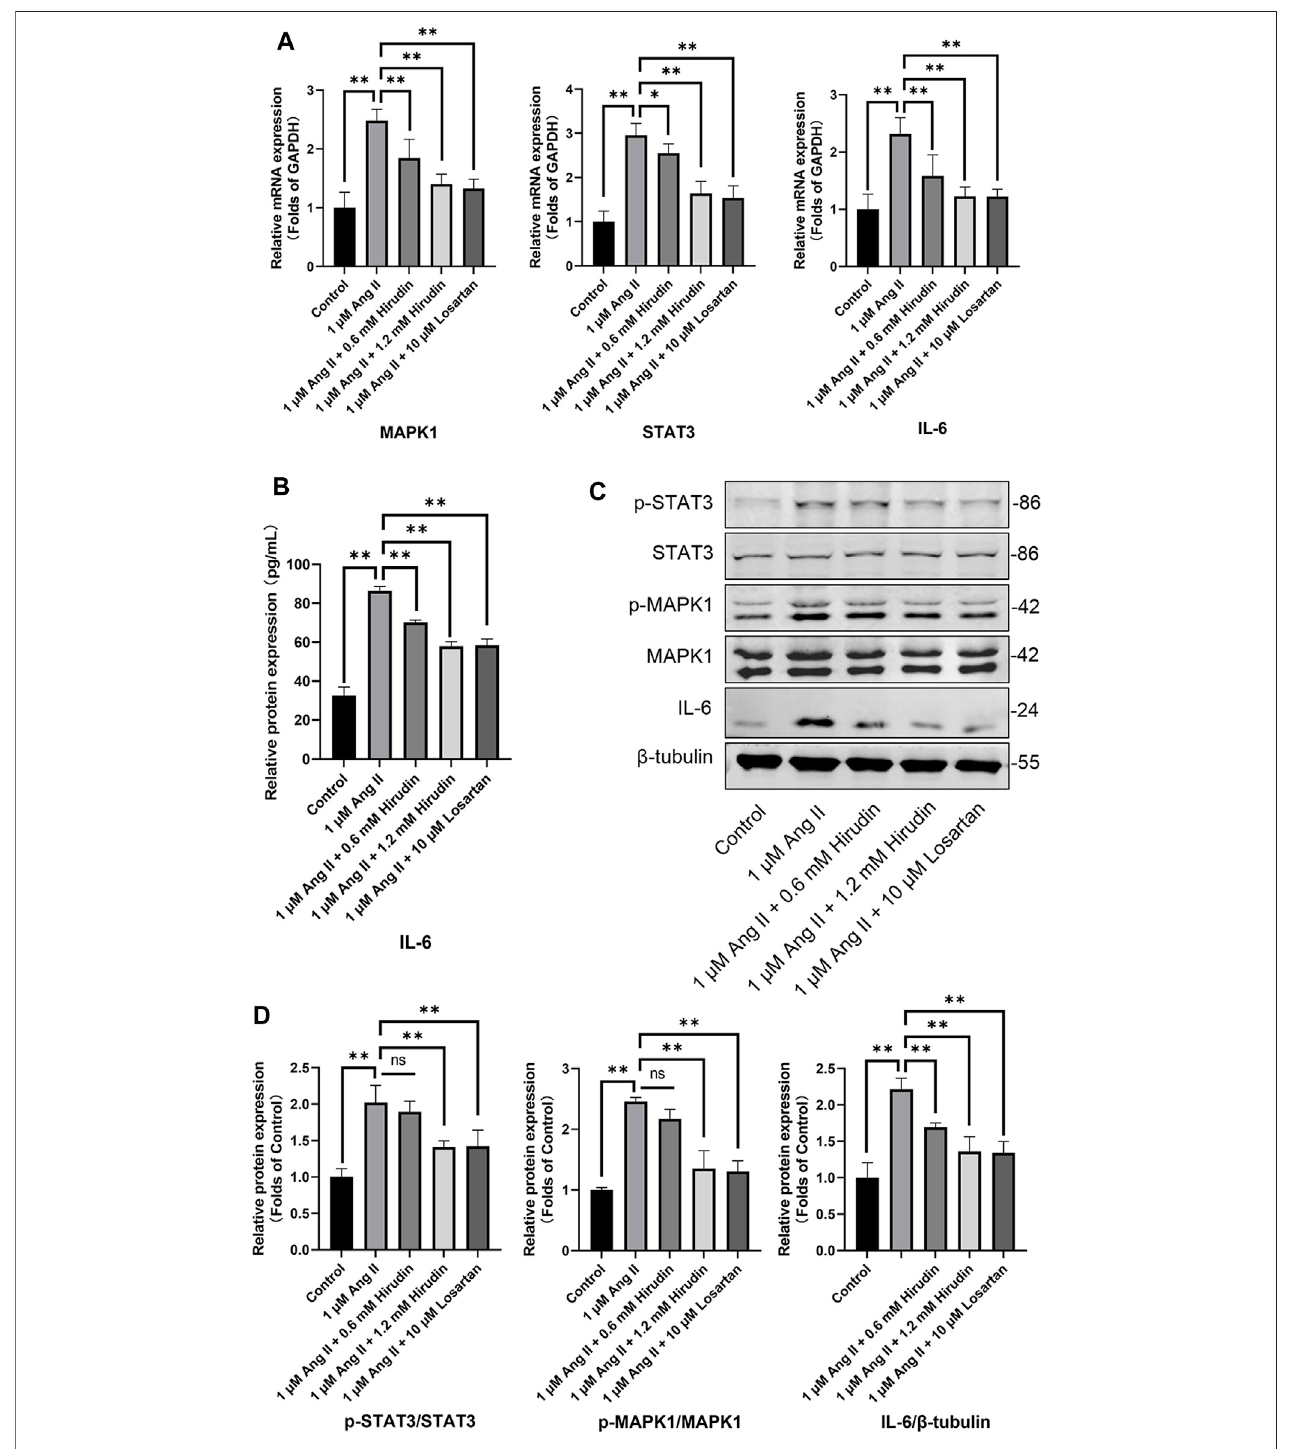
FIGURE8| H9c2cellsweretreatedwith1 μ MAngII,(0.6,1.2 mM)hirudinand10 μ Mlosartanfor24 h,respectively. (A) TheexpressionofSTAT3,MAPK1andIL-6 were analyzed by qRT-PCR, n = 6. (B) The IL-6 in cell supernatant was assayed by ELISA, n = 5. (C) Western blot for the expression of proteins including STAT3, p-STAT3, MAPK1, p-MAPK1 and IL-6. (D) Quanti fi ed by western blot analysis and normalized to control, n = 3. Bars represent the mean ± SD, * p < 0.05, ** p < 0.01.